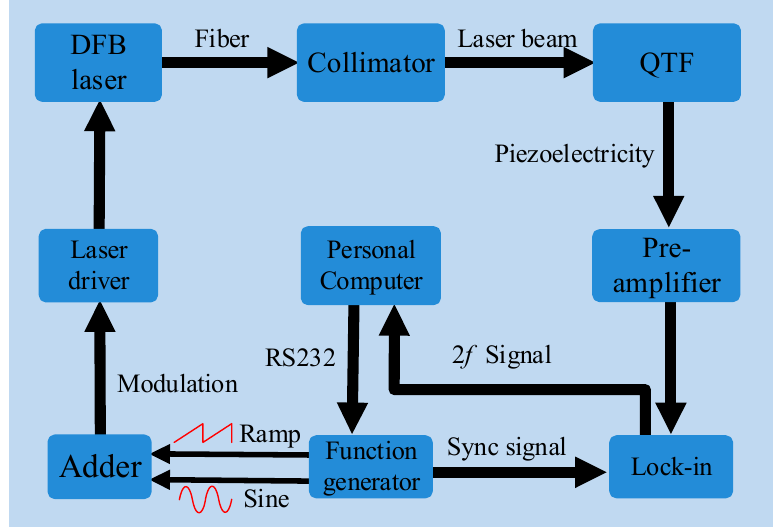
Figure 3. Schematic diagram of the quartz-enhanced photoacoustic spectroscopy (QEPAS) experimental setup. The double channel function generator produces ramp and sine signals to tune and modulate the laser wavelength, respectively. QTF: quartz tuning fork, DFB lasers: distributed feedback lasers, Lock-in: lock in amplifier.